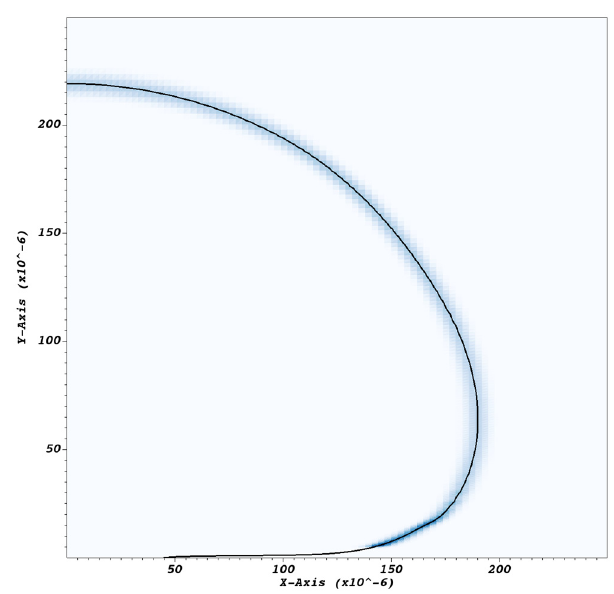
Figure 5. Visualization of indicative distribution of the volumetric rate of mass transfer imposed at the bubble curved surface in order to mimic bubble growth due to evaporation. The black line represents the vapor–liquid interface; the shaded region indicates where mass transfer is imposed.